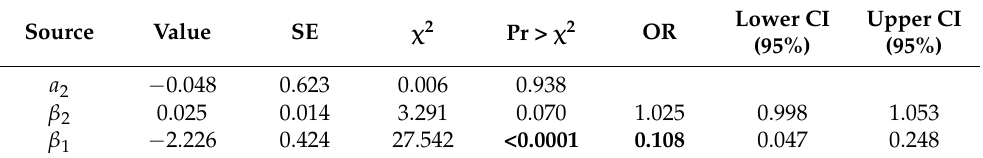
Table 4. The parameters of the logistic model characterizing the relationship between the variable Y 1 : “Have you been infected with COVID-19?”and the variables X 2 and Z 2 (Model 2). Bold values indicate a statistically significant impact.